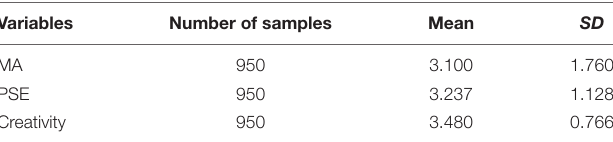
TABLE 1 | Descriptive statistical analysis for the observed